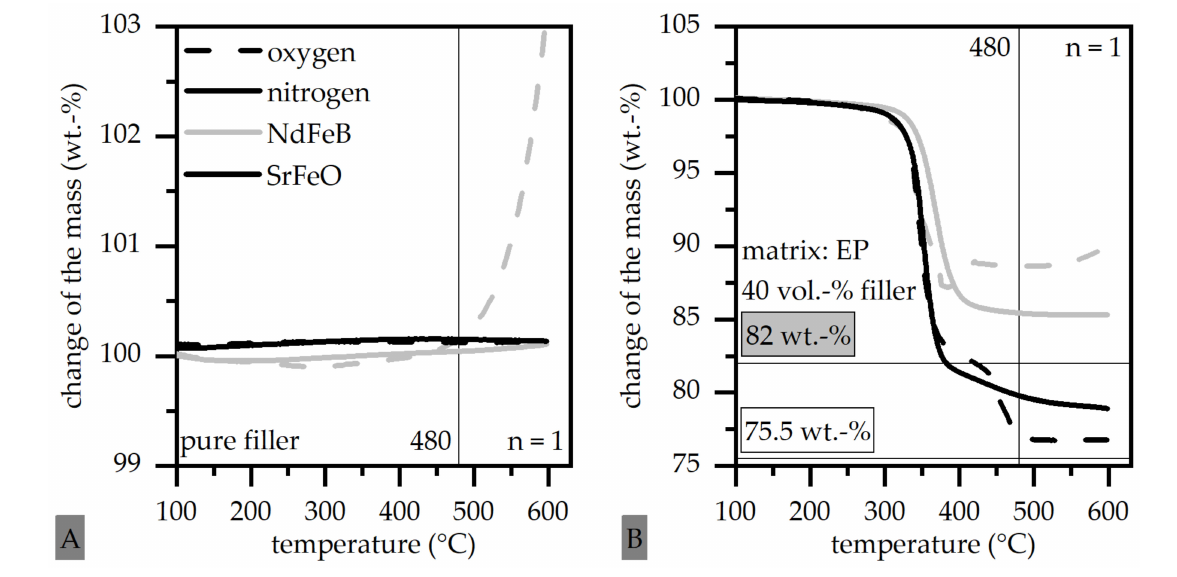
Figure 10. Change of the mass of pure filler ( A ) and compound with 40 vol.-% ( B ) of NdFeB and SrFeO with oxygen or nitrogen atmosphere.